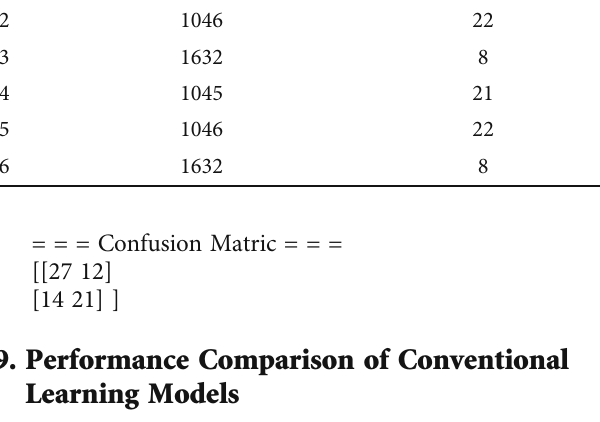
Table 1: Summary results of conventional learning model performance. Number of radiomic Templates data